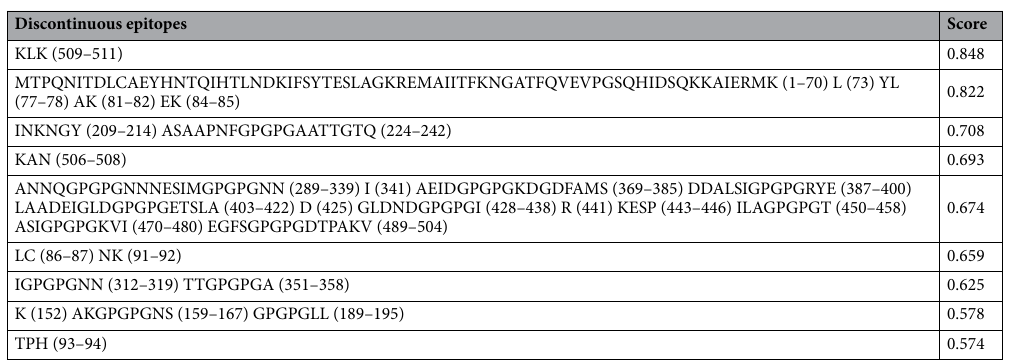
Table 4. Discontinuous/conformational B cell epitopes as predicted by ElliPro server.